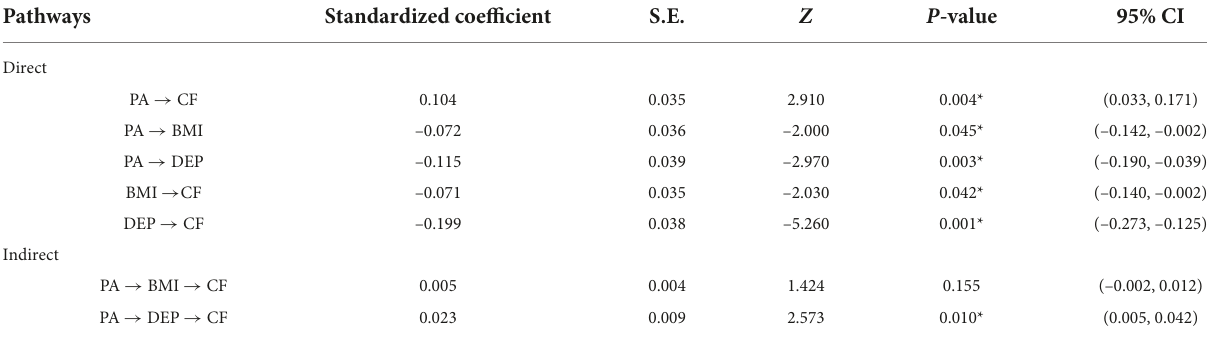
TABLE 3 Parallel mediation analysis results.